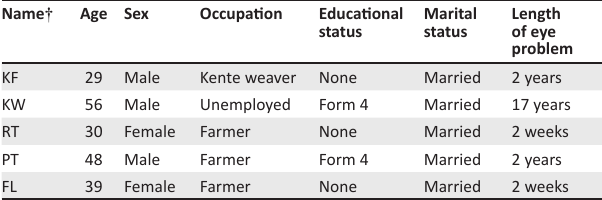
TABLE 4: Background characteristics for case